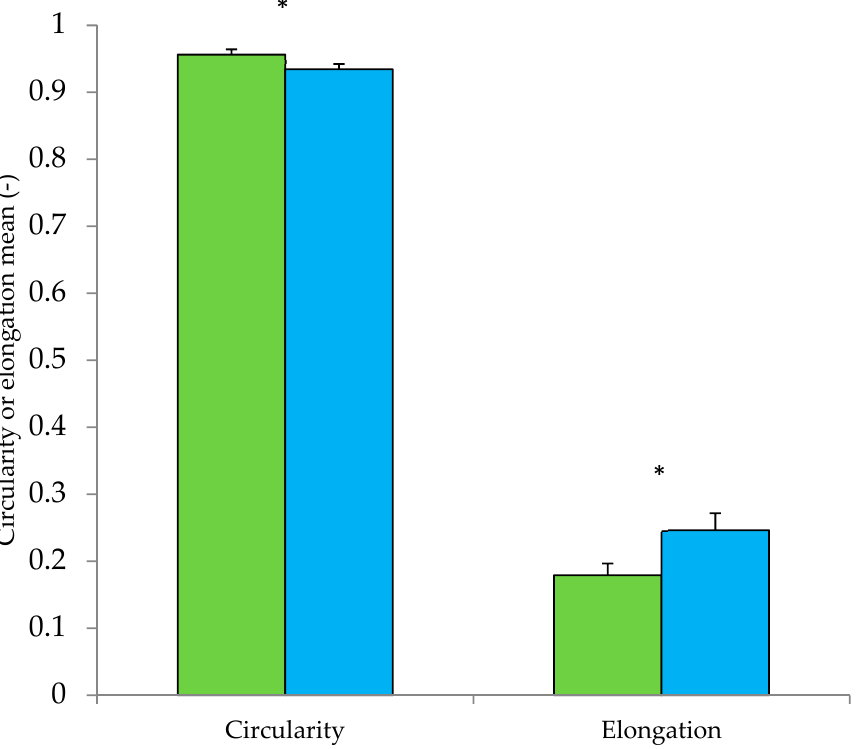
Figure 3. Circularity and elongation mean of Type I ( green fill ) and Type II ( blue fill ) powders. * denotes significant difference ( p < 0.05) between columns. Note: Type I powders were made from intact proteins and did not contain large lactose crystals; Type II powders were made from intact proteins and contained large lactose crystals.